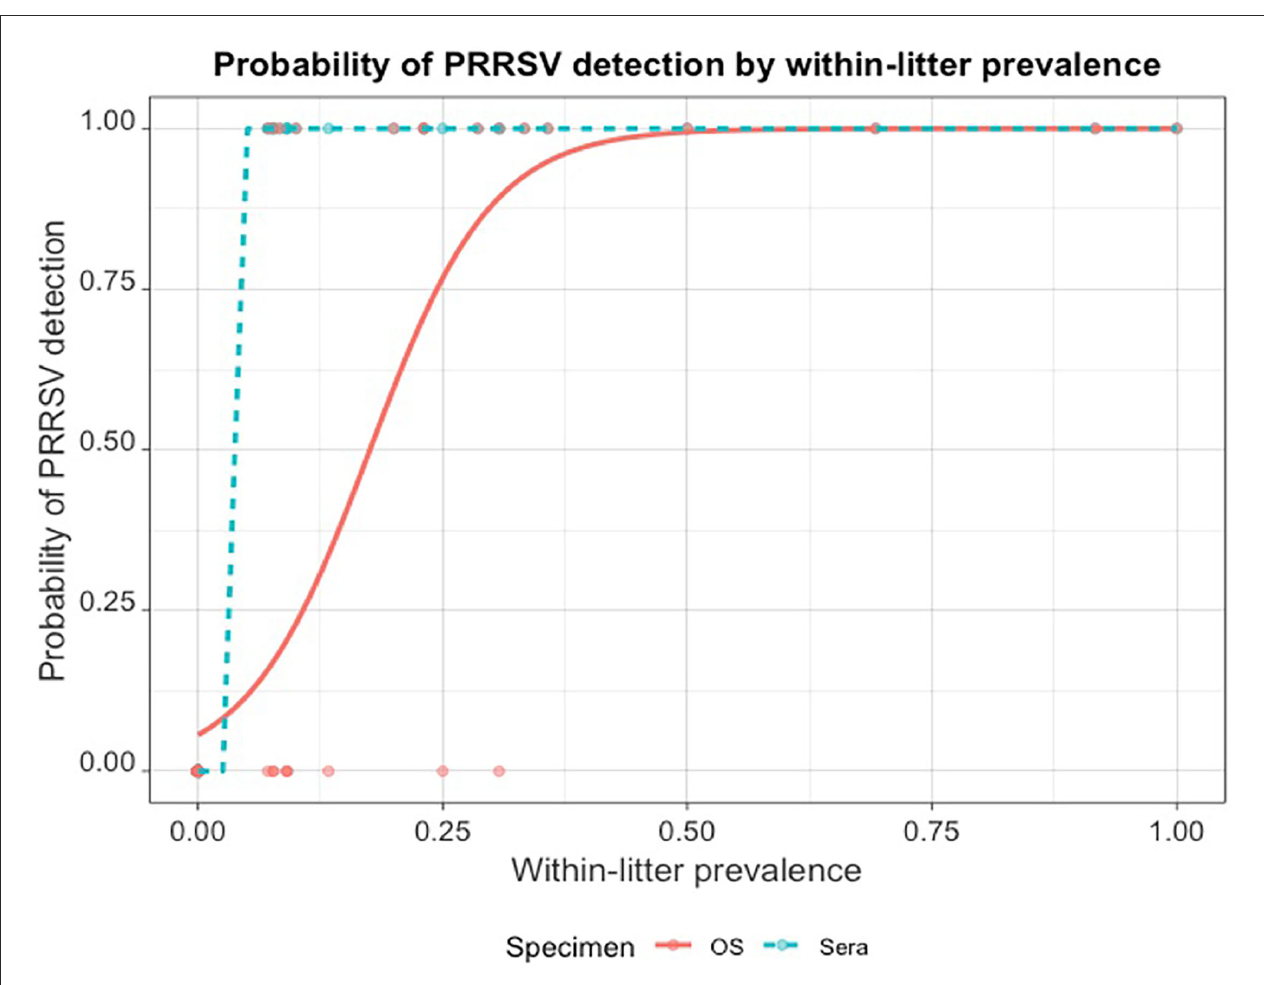
FIGURE2 Probability of PRRSV RT-rtPCR detection in at least one pig when litters are fully sampled by oral swabs (OS) compared to within-litter prevalence established by serum